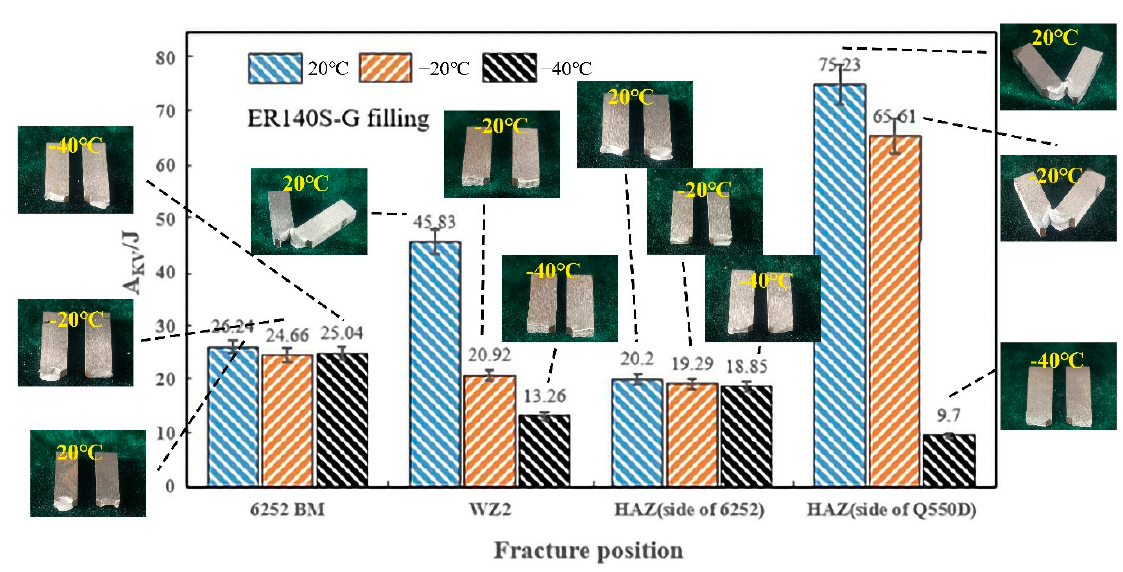
Figure 11. A KV of various specimens at different temperatures (ER70S-G).